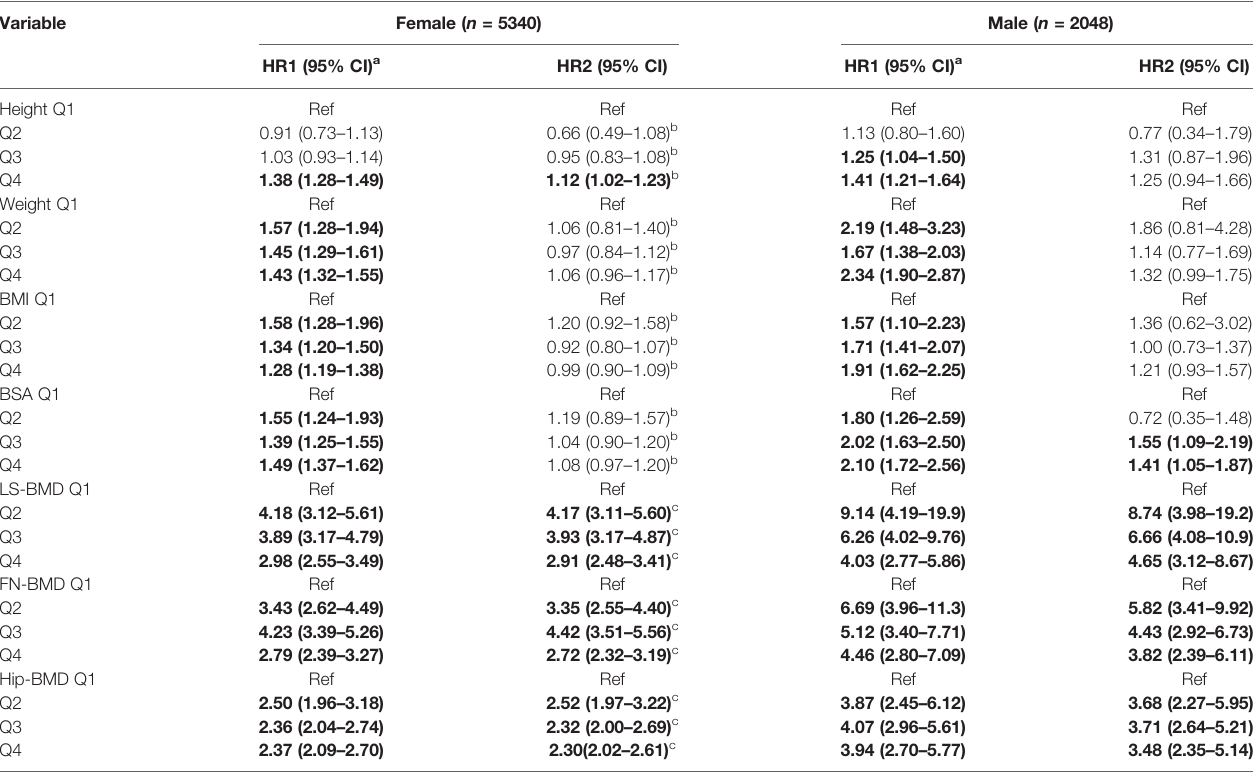
TABLE 3 | The effect of anthropometry and BMD strati fi cation on fracture hazard ratio (HR).